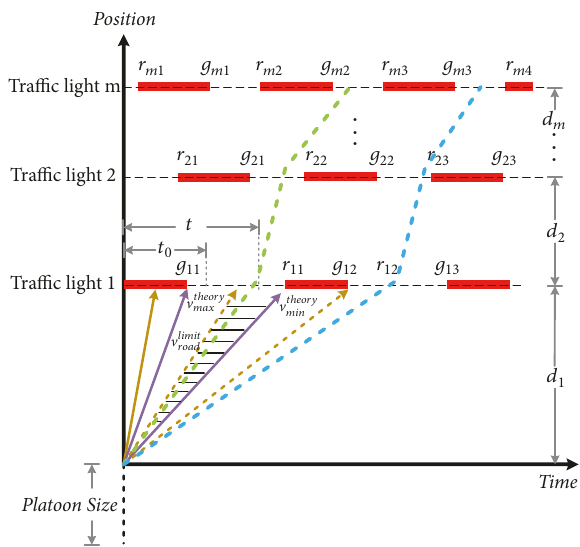
Figure 3: Allowable velocity bound for